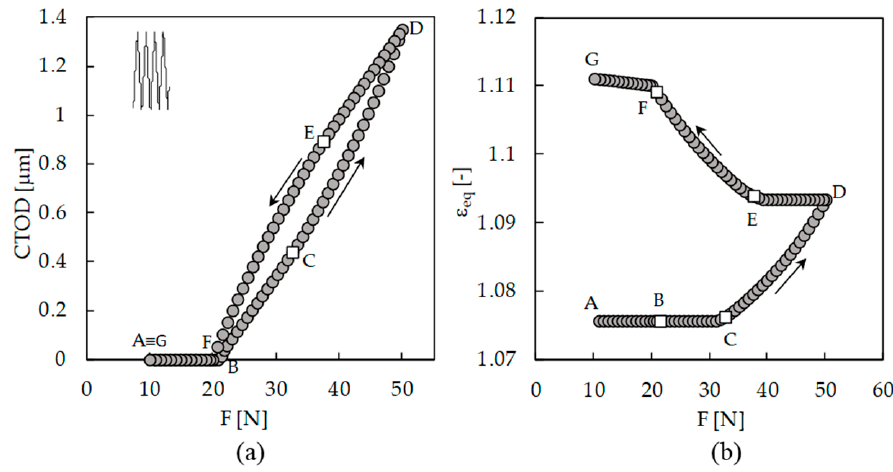
Figure 8. ( a ) CTOD versus load. ( b ) Cumulative plastic strain at crack tip versus applied load ( F max = 50 N; F min = 10 N).